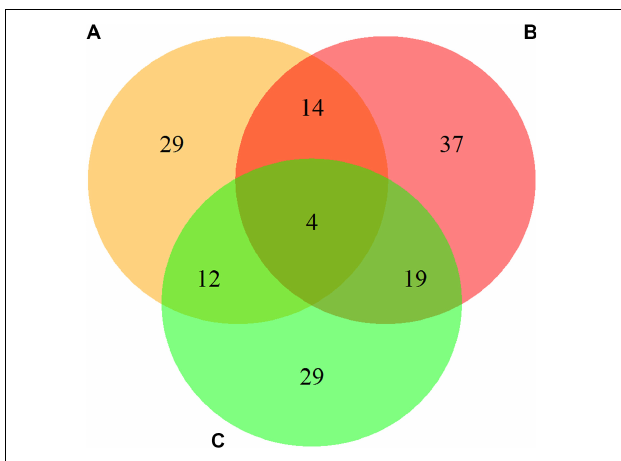
FIGURE 1 | The overlap among the differentially expressed proteins in the germinated Pst urediospores in the combinations CYR32-5 vs. CYR32 (A) , CYR32-61 vs. CYR32 (B) , and CYR32-61 vs. CYR32-5 (C) (For each combination, the proteome of the former was compared with that of the latter to screen the differentially expressed